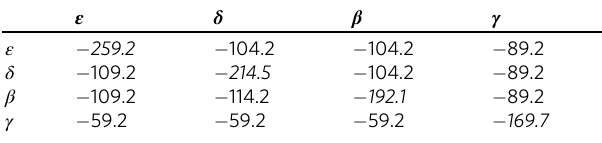
Table 1 Lid energies at which transitions are located between γ , β , δ and ε in threshold sampling in space groups P 1 (upper right entries) and P 2 c (lower left 1 /